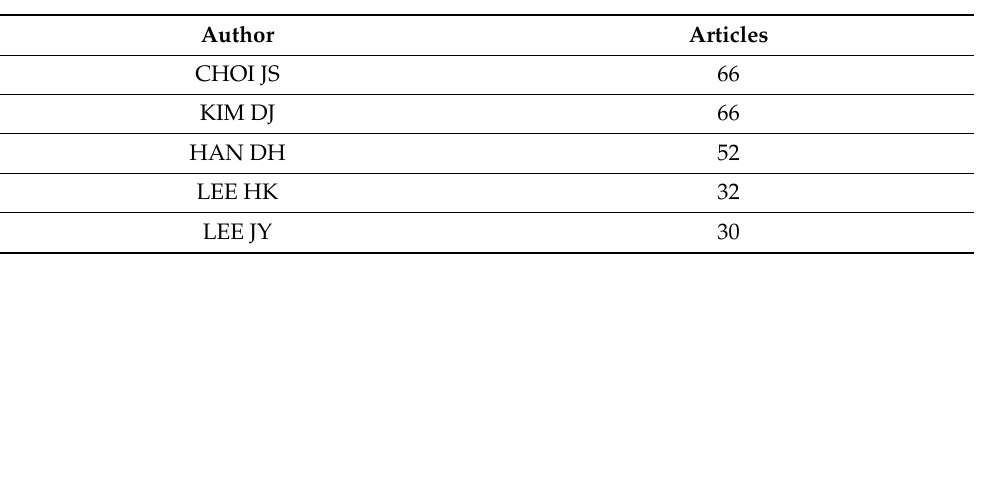
Table 2. The top 20 most productive authors in